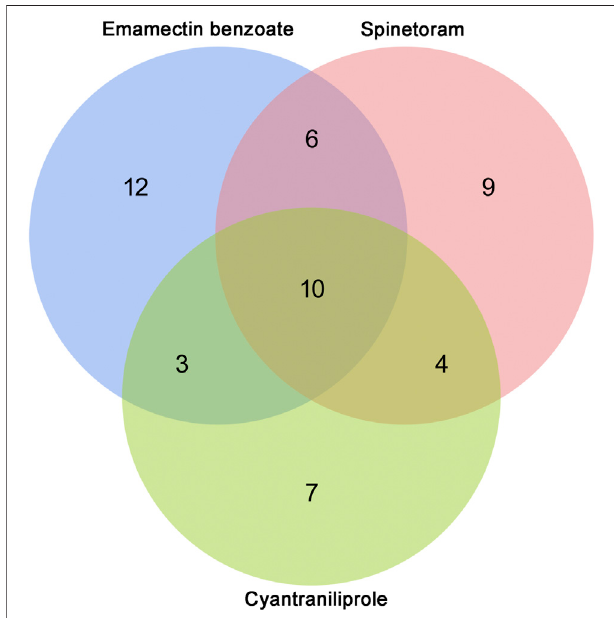
FIGURE 5 | Venn diagram of differentially expressed miRNAs after cyantraniliprole, spinetoram, and emamectin benzoate treatment.